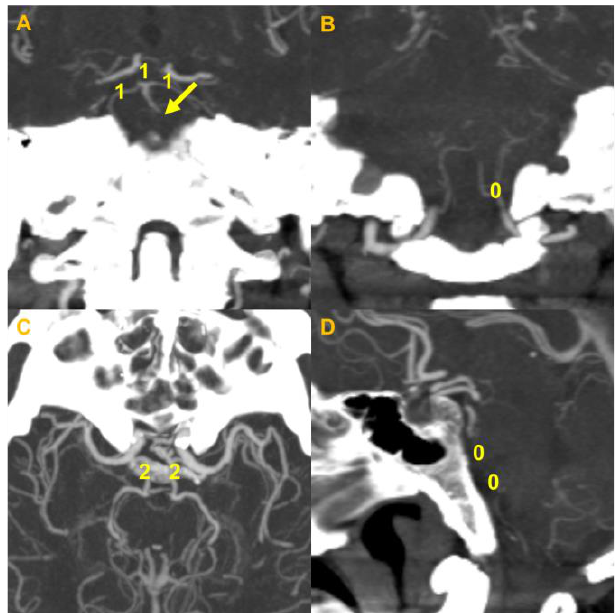
Figure 3. An example of a BATMAN score from a truncal-type occlusion from the cohort. ( A ) Coronal reconstruction of the MIP image of the basilar artery. Occlusion at the vertebrobasilar artery with visualization of the distal part and the basilar top is seen. Both PCAs are visualized. For the BATMAN score, each 1 point is given for the distal BA, and both PCAs. ( B ) Coronal MIP image of bilateral VAs. Note that both VAs are occluded. Zero point was given. ( C ) Axial MIP image showing both posterior communicating arteries. Two points for each communicating artery was given. ( D ) Sagittal MIP image showing occluded proximal and mid-BA. Zero points were given for each part of the BA, constituting a total BATMAN score of 7. BATMAN, Basilar Artery on Computed Tomography Angiography; BA, basilar artery; MIP, maximal intensity projection; PCA, posterior cerebral artery; VA, vertebral artery.